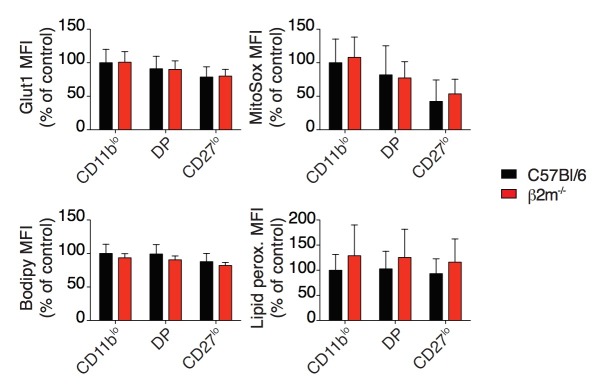
Bar graphs showing MFI of Glut1 staining, MitoSox staining, Bodipy incorporation and Lipid peroxidation staining of splenic NK cell subsets from C57BL/6 or β2m-/- mice (mean +SD, n=10 mice of each genotype in 3 independent experiments, except Glut1: 4 mice in 2 independent experiments, no statistical differences were detected between C57BL/6 and β2m-/-, t-test).MFI were normalized to the CD11blo subset of C57BL/6 mice.